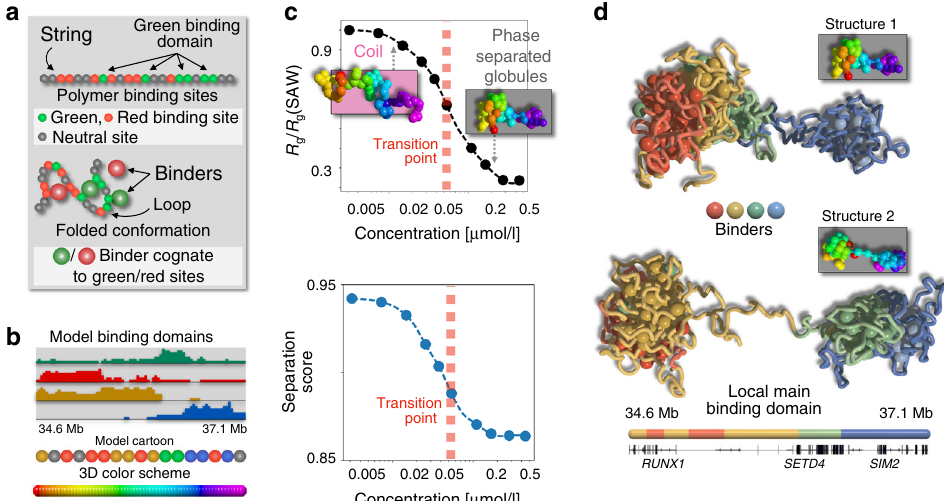
Fig. 1 The model phase transition from a coil to a globule phase separated state. a Cartoon of the Strings and Binders (SBS) polymer model of chromatin showing the speci fi c binding sites along the chain (top) and a 3D conformation of the system folded by the action of cognate binders (bottom). b The SBS model of the studied chr21:34.6-37.1 Mb locus in human HCT116 cells has four types of binding sites, forming four binding domains each represented with a different color. Their genomic location and abundance are shown. A cartoon is sketched (bottom) of the model polymer chain and the color scheme used in the 3D representations in c ). c Upon increasing the binder concentration, the model has a phase transition from a coil to a globule phase separated state, a more condensed structure made of partially separated globules, as signaled by a sharp decrease of the system order parameters, respectively the equilibrium gyration radius R g (top) and average separation score (bottom). d The intrinsic degeneracy of the globule phase separated state, enhanced by the overlapping genomic organization of the binding domains, corresponds to a variety of 3D conformations: two structures are shown where, for example, the green binding domain collapses respectively onto the brown and the blue